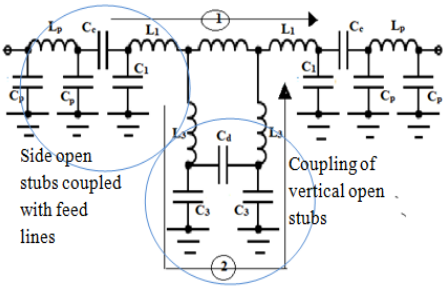
FIGURE 8. Functional circuit of proposed Dual BPF